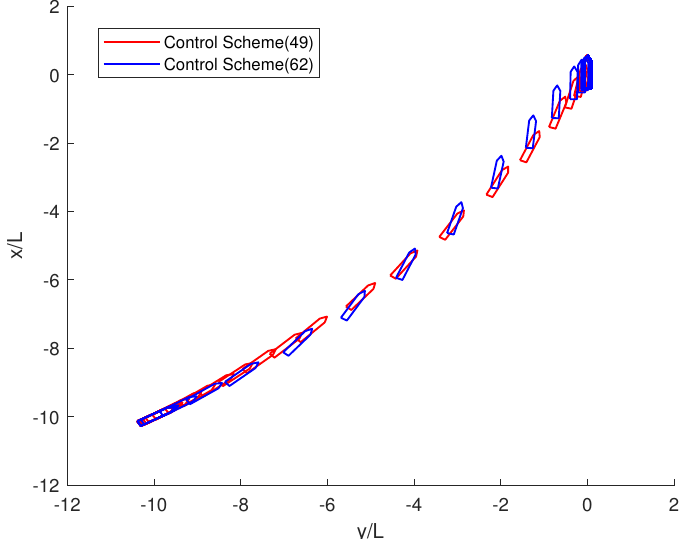
Figure 2. Berthing path comparison of between control scheme Equation (49) and control scheme Equation